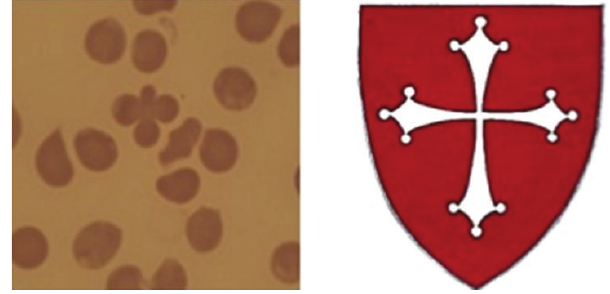
Figure 10: qRBCs are resembling the Pisa middle ages